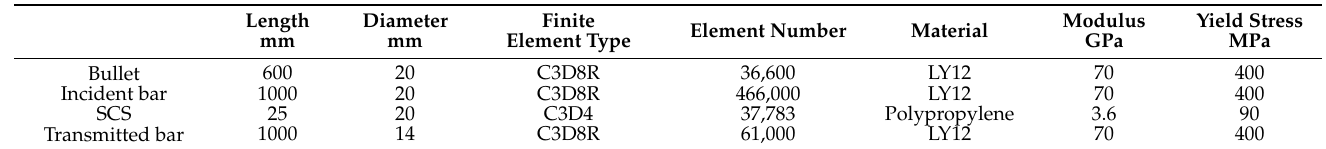
Table 6. Model parameters of finite element analysis (FEA).